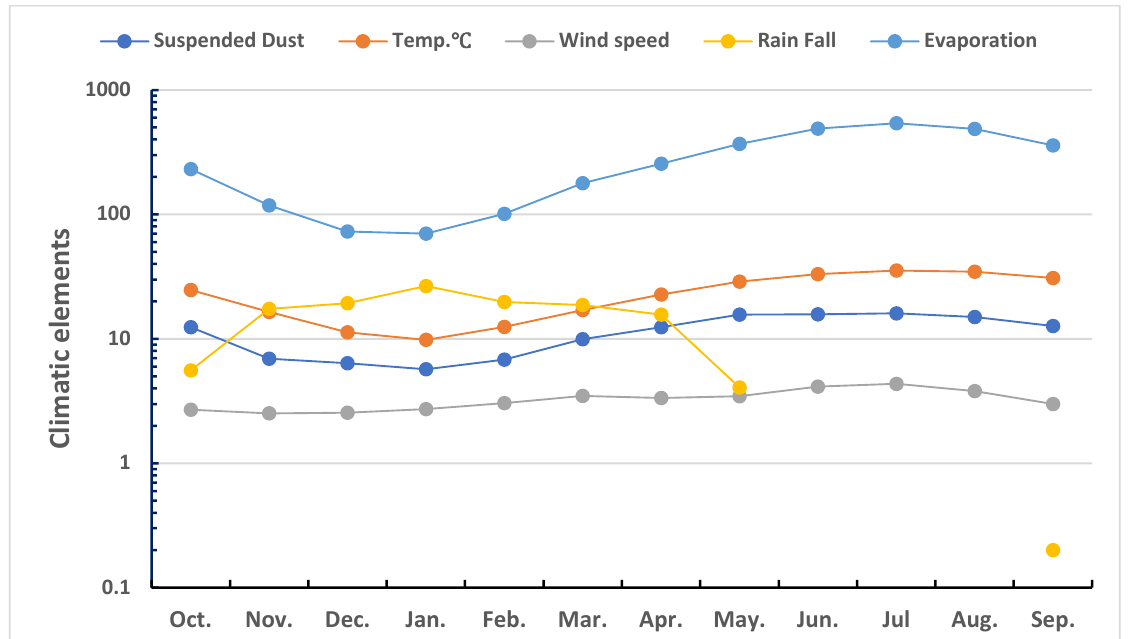
Figure 8. Monthly model analysis of the climatic elements for 60 years (1960 – 2020); every variable is at logarithmic scale.